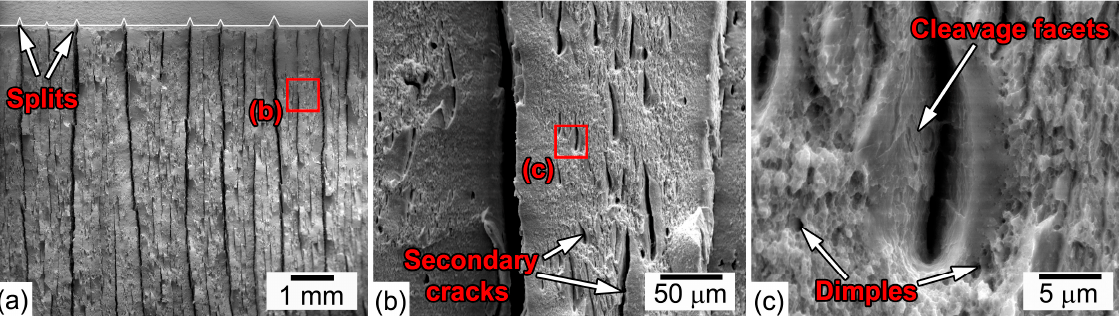
Figure 8. SEM images of typical sawtooth fracture surface of the steel after the impact test of the TD–Charpy V-Notch specimen at room temperature. Tempforming at 600 ° C, ε = 1.4. ( a ) General view of fractured impact specimen, ( b ) secondary cracks between splits ( c ) high-magnification of typical secondary cracks morphology and surface around them.